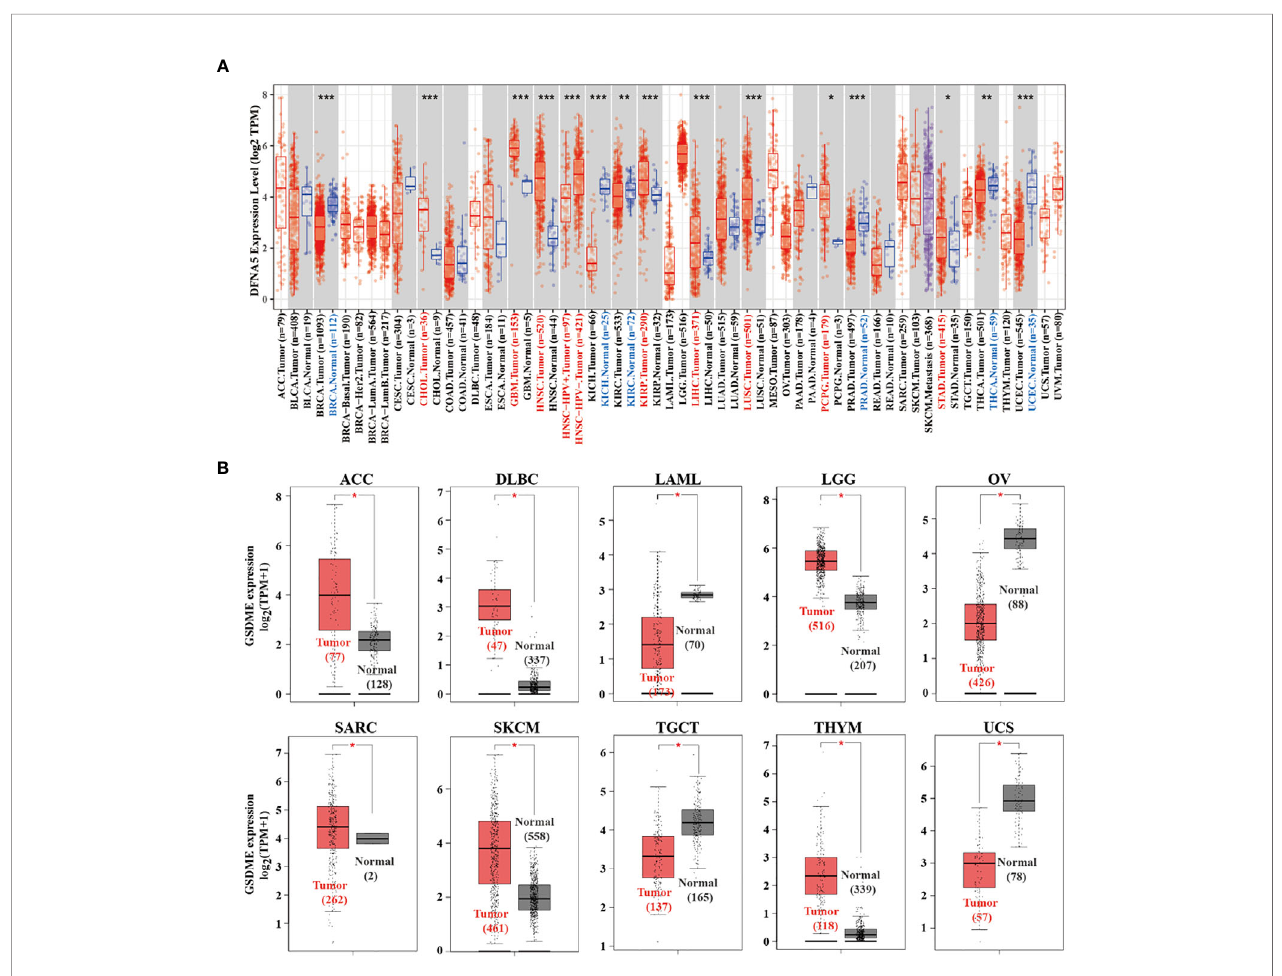
FIGURE 1 | (A) The expression difference of the GSDME in diverse cancers or certain cancer subtypes was analyzed via TIMER2 algorithm. (B) For ACC, DLBC, LAML, LGG, OV, SARC, SKCM, TGCT, THYM, and UCS in the TCGA database, the adjacent normal tissues of the GTEx project were included as controls. The box plots were then graphed. *P < 0.05, **P < 0.01, ***P <